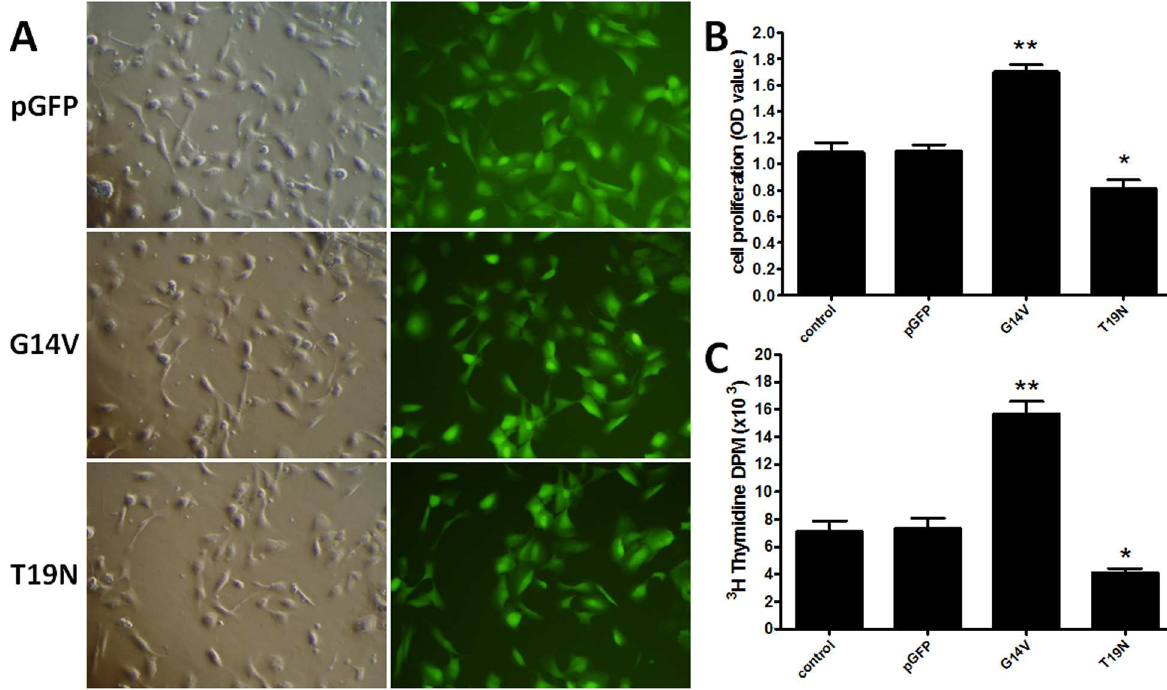
Fig 2. Effect of RhoA on huESC proliferation. (A) Transfectionof RhoA (+/+) (G14V), RhoA (-/-) (T19N) or pGFP control plasmid(1.5 μ g/ ml each plasmid)into huESCs using Lipofectamine transfectionreagent. (B) After transfection, cell proliferation was quantitated using a CCK-8 assay accordingto the manufacturer’s instructions. (C) DNA synthesis was quantified based on [ 3 H]-thymidineuptake in disintegrations per minute (DPM). * P < 0.05versus control, ** P < 0.01versus control. Data are shown as the mean ± SD of duplicate experiments on samples from three different donors (unpaired, two-tailedStudent’st-test).